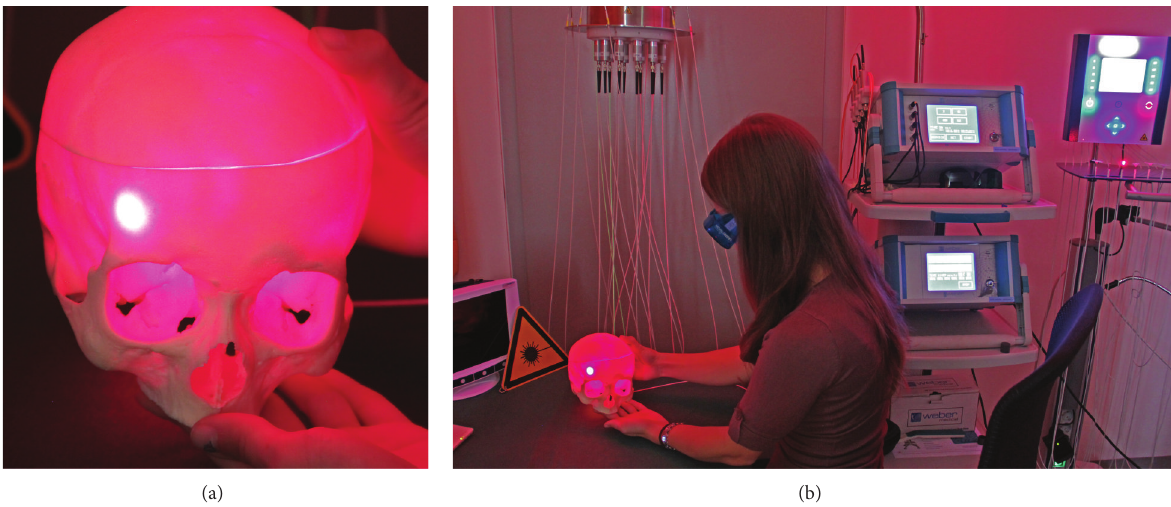
Figure 1: Different kinds of laser equipment for transcranial laser stimulation.